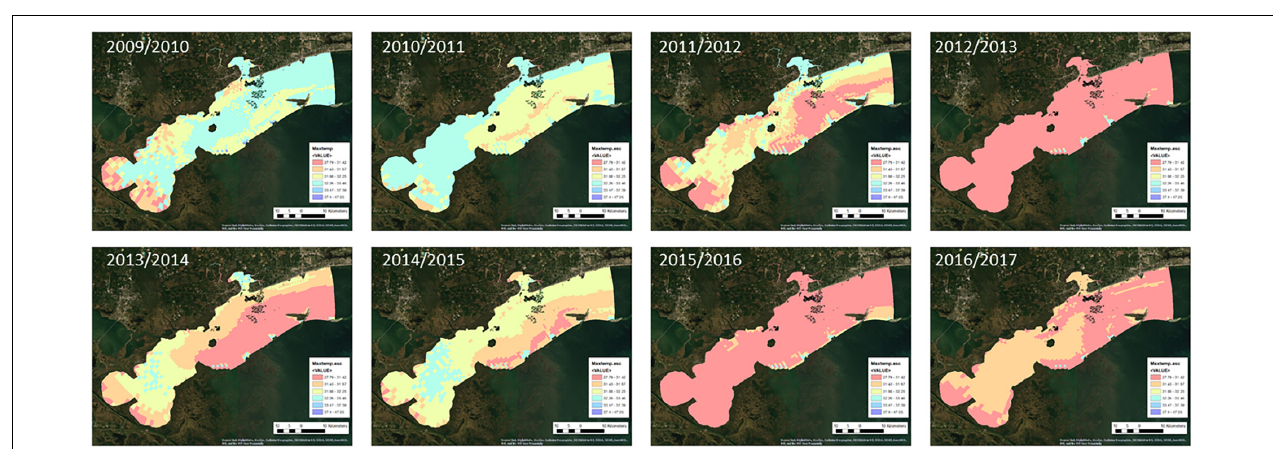
FIGURE 4 | Maximum daily temperature per oyster